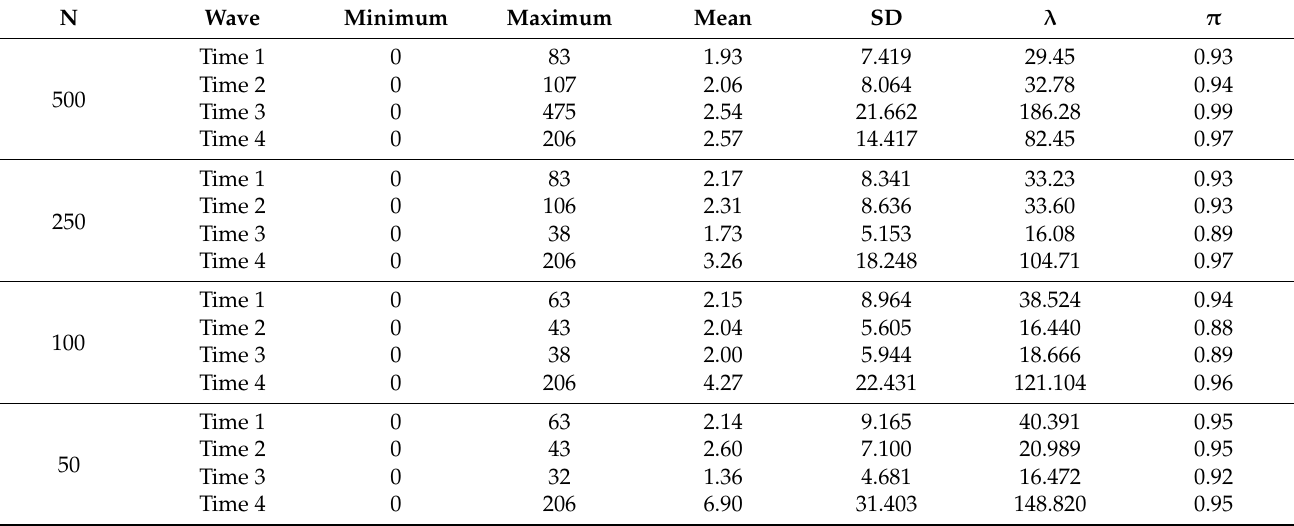
Table 1. Descriptive statistics and ZIP parameters for all four waves for the different sample sizes *.